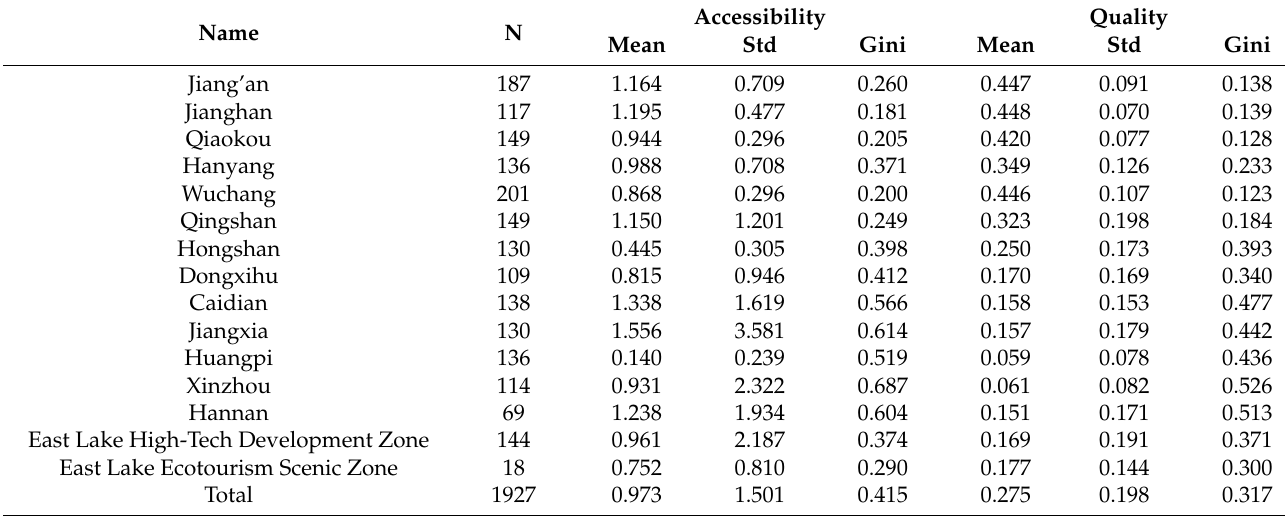
Table 5. Statistical results on educational accessibility and educational quality in each district.